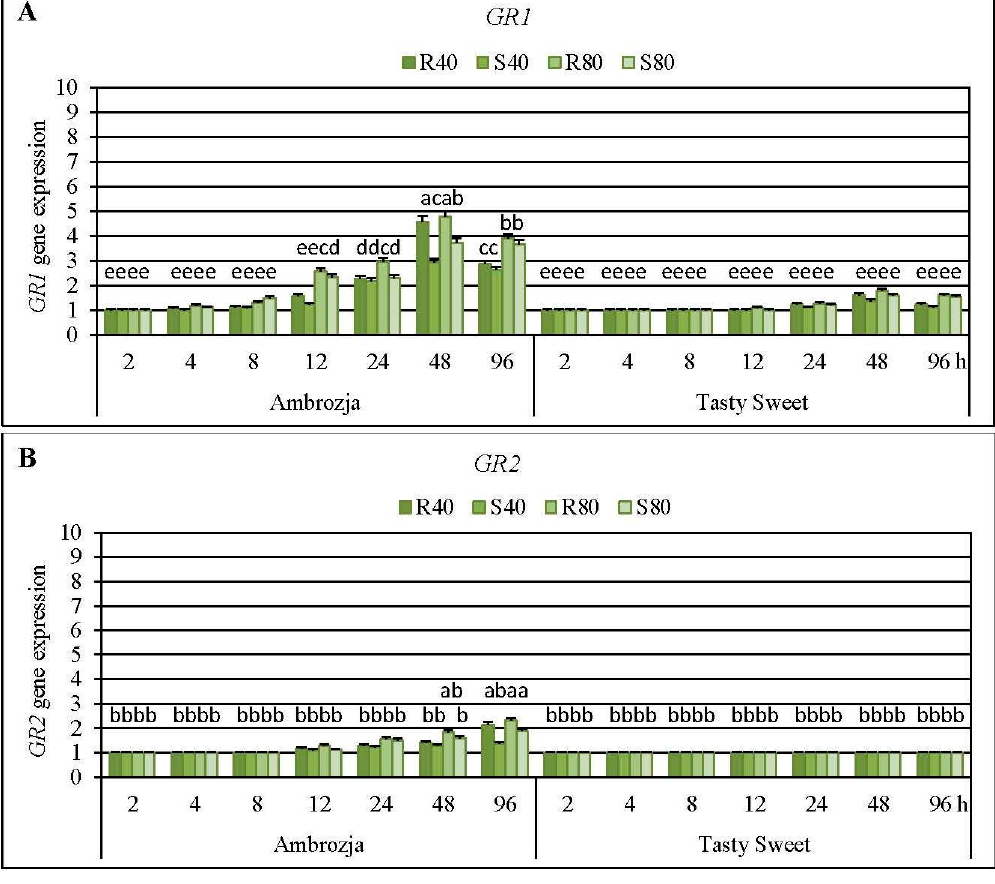
Figure 8. Influence of the cereal aphid’s attack on relative expression of GR1 ( A ) and GR2 ( B ) genes in the seedlings of Ambrozja and Tasty Sweet maize varieties (first phase of the experiments). R40, R80–maize plants of a certain genotype infested with 40 or 80 R. padi females per seedling, accordingly; S40, S80–maize plants of a certain genotype infested with 40 or 80 S. avenae females per seedling, respectively. All data are presented as the mean (±SD) of three independent biotests, and significant differences in abundance of the GR transcripts are denoted by different letters ( p < 0.05; post-hoc Tukey’s test).